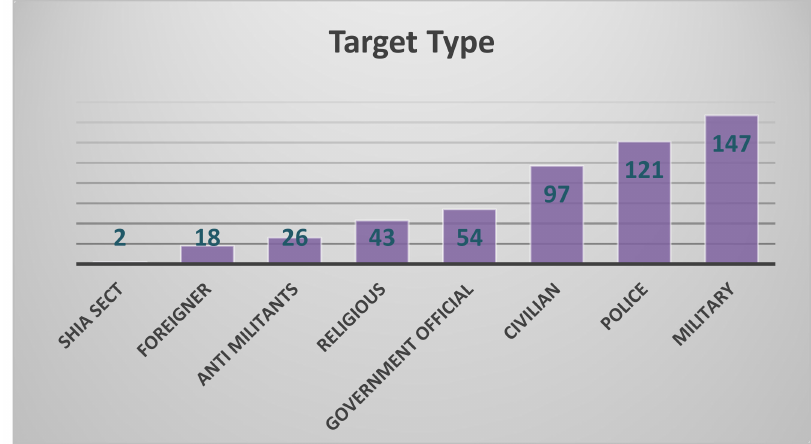
Figure 2. Visual analysis of the type of people targeted in suicide bombing.